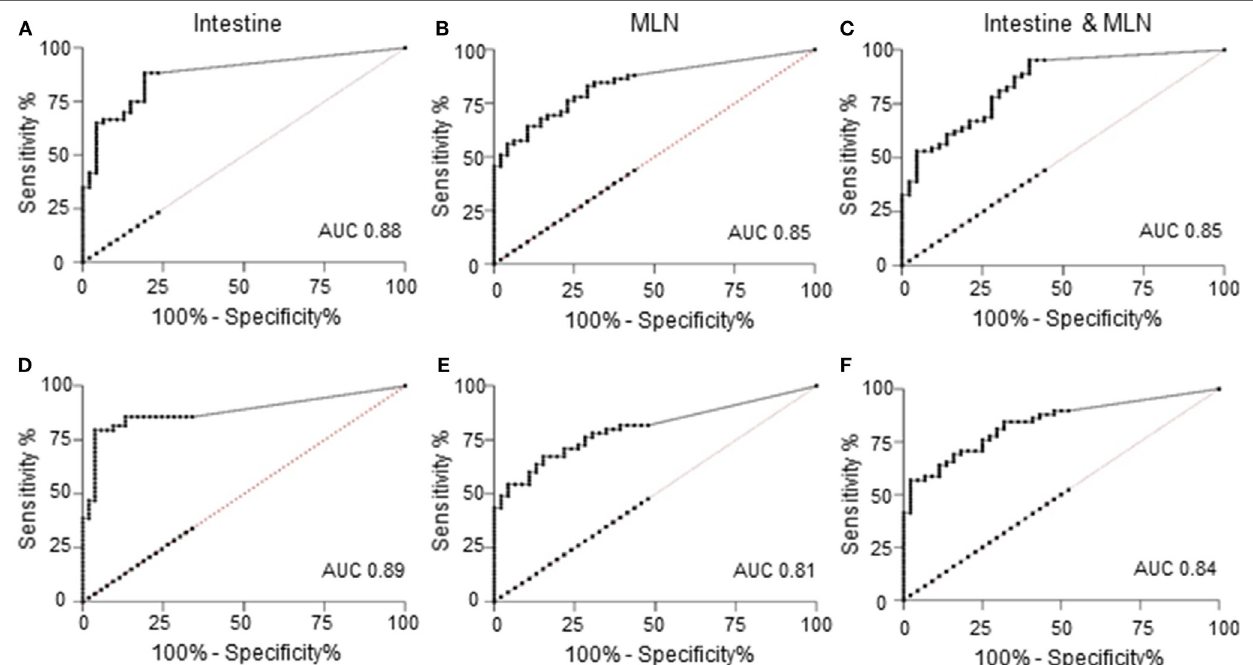
FigUre 1 | Receiver operating characteristic (ROC) curves of quantitative results of quantitative PCR (qPCR) versus reference tests; tissue culture (a–c) or histopathology (D–F) . (a) ROC curve of qPCR of intestine against culture results as reference test. Area under the curve (AUC) was 0.88 [95% confidence interval (CI): 0.82, 0.95], and at a cutoff of > 0.00054 pg, the sensitivity was 88.33% (95% CI: 77.43%, 95.18%), and the likelihood ratio was 4.16. (B) ROC curve of qPCR of mesenteric lymph node (MLN) against culture results as reference test. AUC was 0.85 (95% CI: 0.77, 0.92), and at a cutoff of > 0.00052 pg, the sensitivity was 86.44% (95% CI: 75.02%, 93.96%), and the likelihood ratio was 2.19. (c) ROC curve of qPCR of intestine and MLN against culture results of both tissues as reference test. AUC was 0.85 (95% CI: 0.78, 0.92), and at a cutoff of > 0.00053 pg, the sensitivity was 95.31% (95% CI: 86.91%, 99.02%), and the likelihood ratio was 2.28. (D) ROC curve of qPCR of intestine against histopathological lesion examination as reference test. AUC was 0.89 (95% CI: 0.82, 0.96), and at a cutoff of > 0.00054 pg, the sensitivity was 85.71% (95% CI: 72.76%, 94.06%), and the likelihood ratio was 2.68. (e) ROC curve of qPCR of MLN against histopathological lesion examination as reference test. AUC was 0.81 (95% CI: 0.72, 0.89), and at a cutoff of > 0.00052 pg, the sensitivity was 81.82% (95% CI: 69.10%, 90.92%), and the likelihood ratio was 1.99. (F) ROC curve of qPCR of intestine and MLN against histopathological lesion examination of both tissues as reference test. AUC was 0.84 (95% CI: 0.77, 0.92), and at a cutoff of > 0.00053 pg, the sensitivity was 89.66% (95% CI: 78.83%, 96.11%), and the likelihood ratio was 1.80.